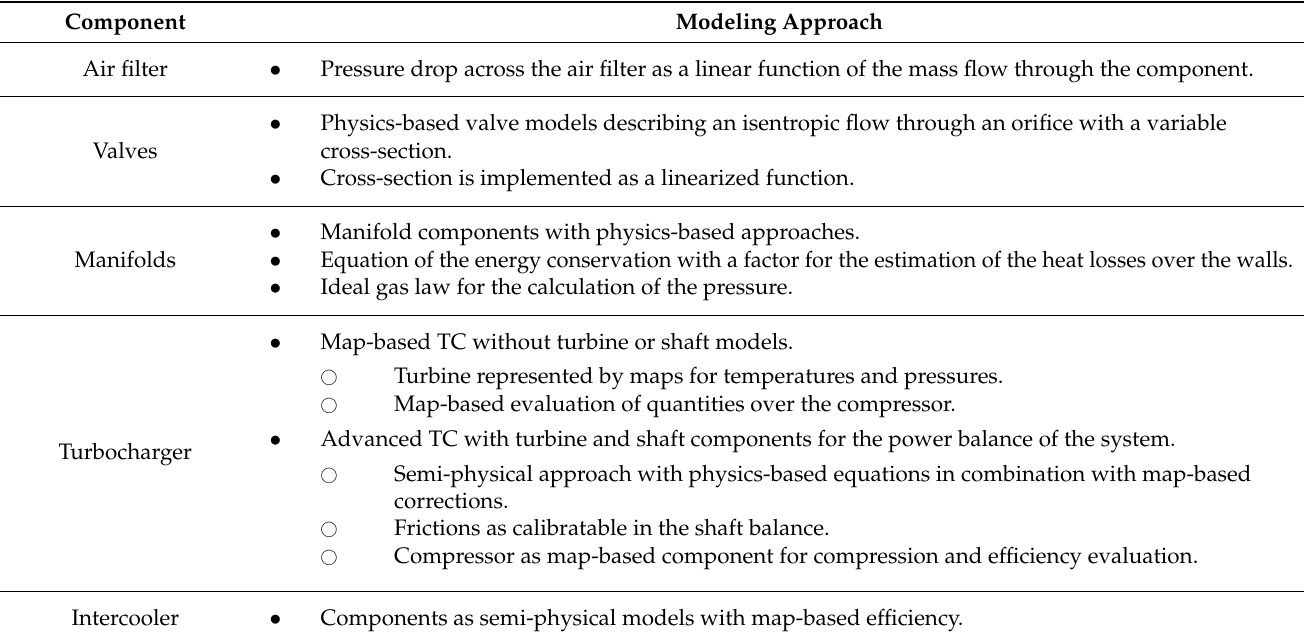
Table 4. Modeling approaches for each component with some